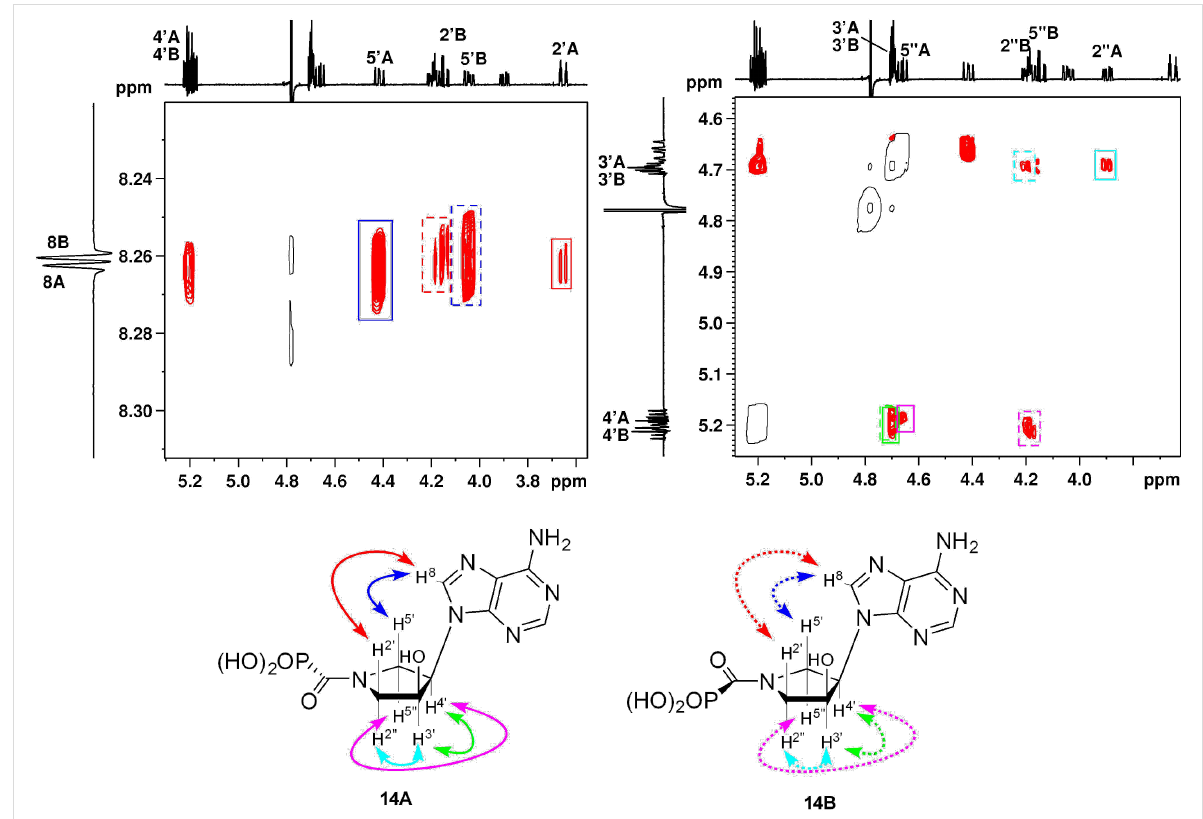
Figure 12: An example of the stereospecific assignment of pyrrolidine-ring protons of 14 in the H,H-ROESY spectrum.